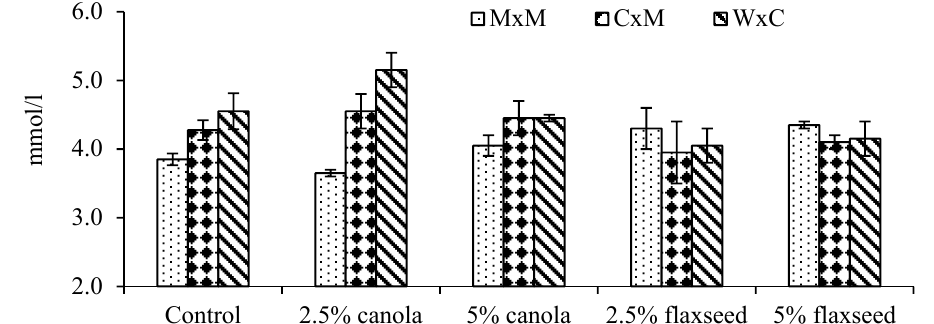
Figure 2. Variations in plasma glucose concentration as influenced by oil supplementation and breed interaction (M × M: Merino × Merino; C × M: Corriedale × Merino; W × C: White Suffolk × Corriedale).